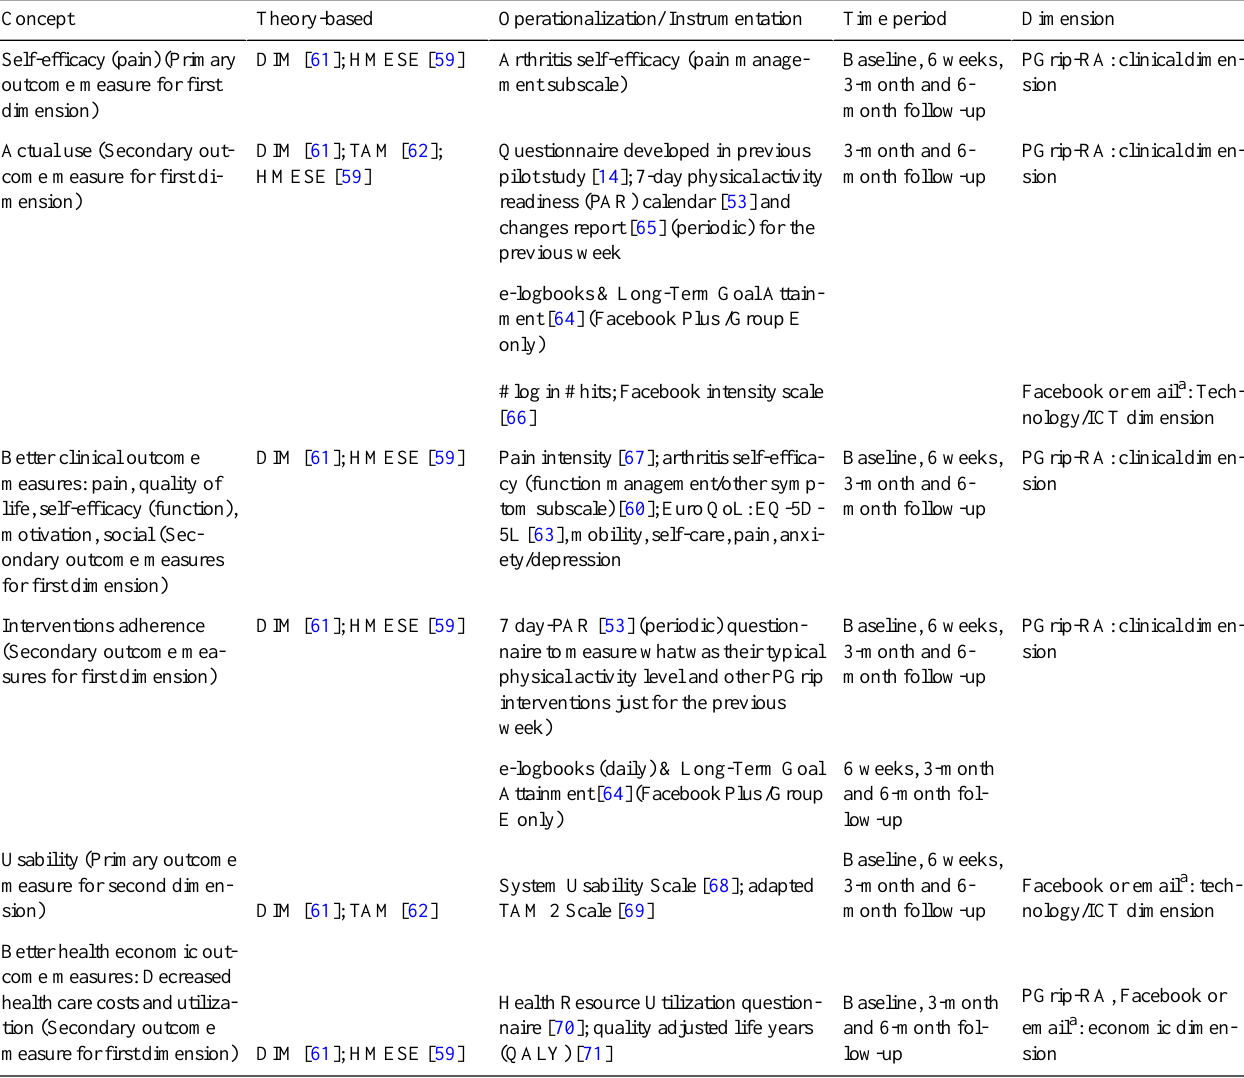
Table 4. Outcome measures according to selected measurement frameworks: KTA evaluated outcomes.